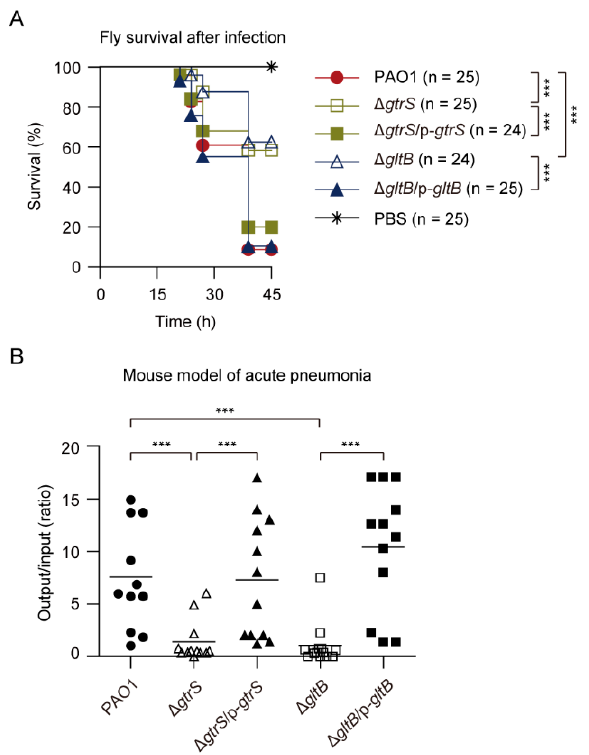
Figure 8. Role of GltB in P. aeruginosa virulence. ( A ) Survival rates of fly upon infection by indicated P. aeruginosa strains. n indicates the number of flies used. Asterisks denote statistical significance determined by log-rank Test: *** p < 0.001. PBS indicates flies was pricked with a sterilized tungsten needle dipped in phosphate buffer saline (PBS) buffer. ( B ) Recovery of P. aeruginosa in a mouse model of acute pneumonia. Results are expressed as the ratio of CFU (colony-forming unit) recovered per lung (output) to CFU present in the initial inoculum (input). Data represent results from n = 10–12 mice per strain; the line shows the geometric mean for each group. The Mann–Whitney test was used to calculate p-values (two-tailed): *** p < 0.001. In all panels, PAO1, Δ gtrS , and Δ gltB harbor an empty pAK1900 vector as control; p- gtrS denotes the pAK1900- gtrS plasmid; p- gltB denotes the pAK1900- gltB